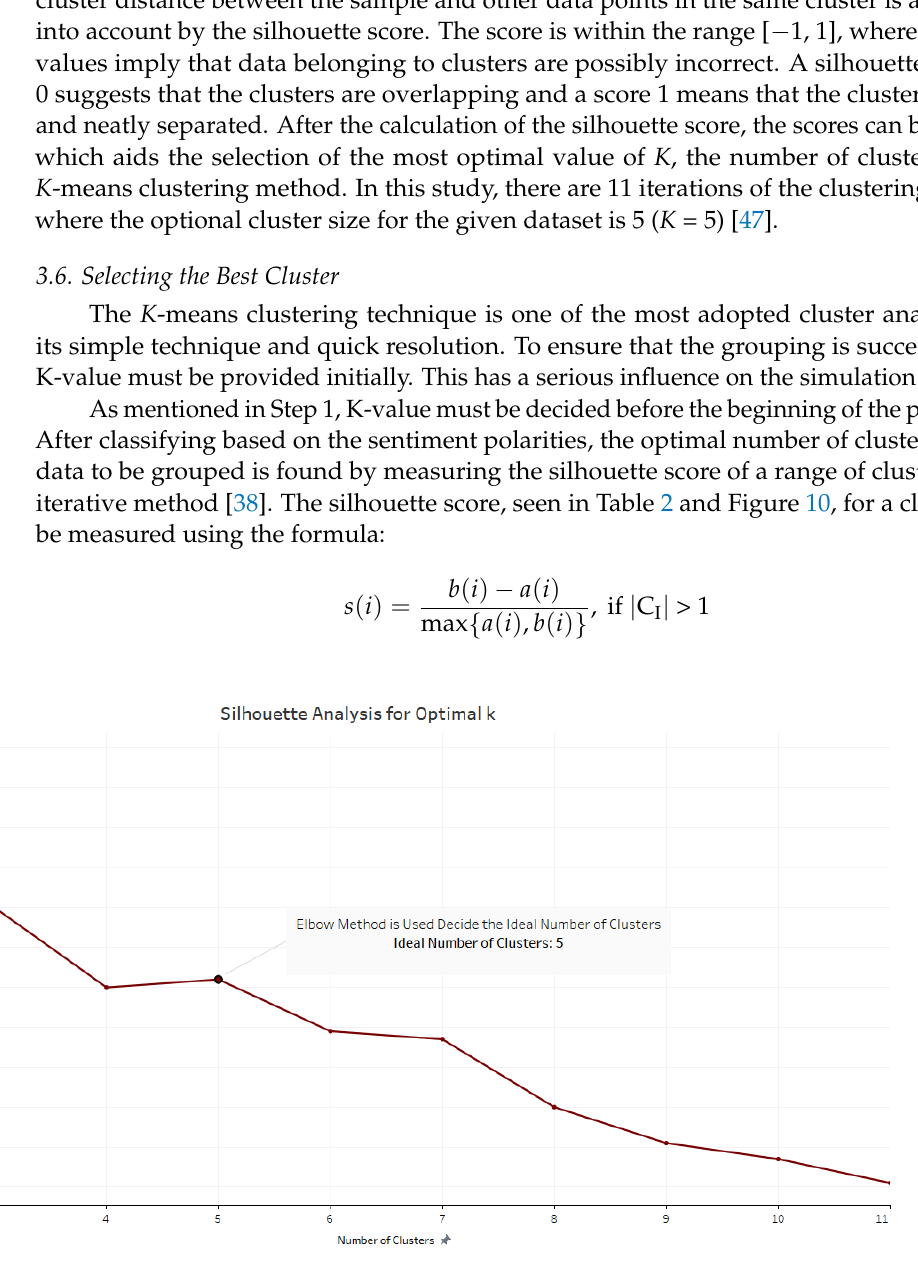
Figure 10. Silhouette analysis to find the optimal k value.